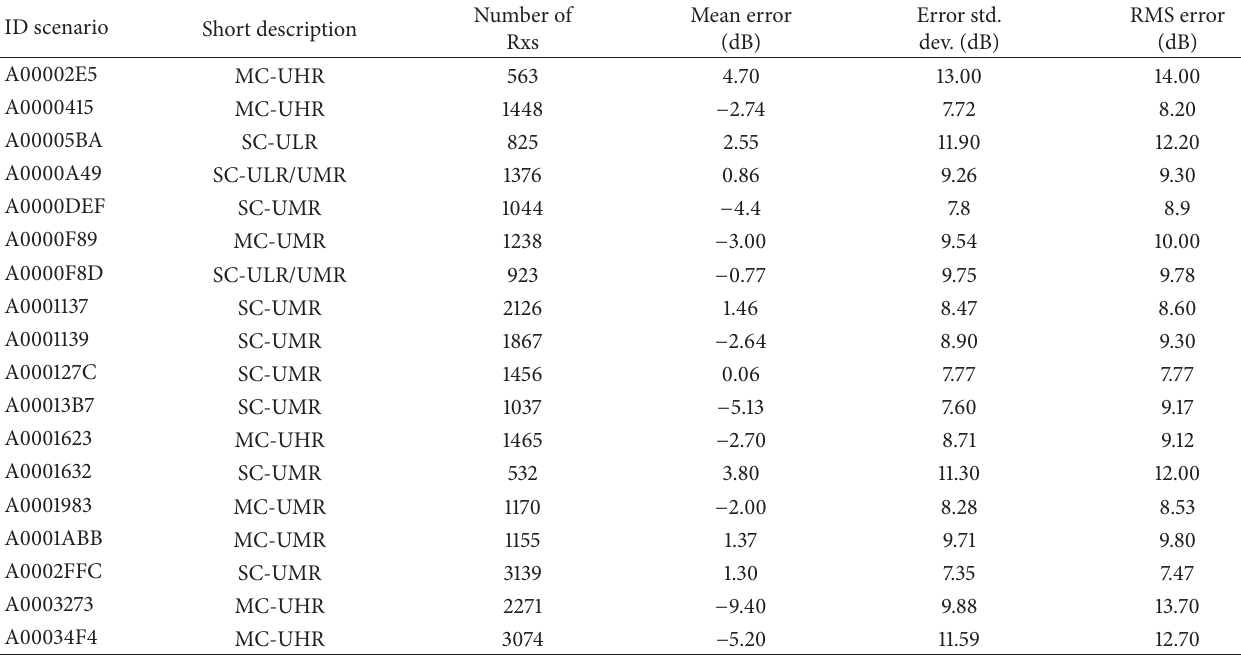
Table 2: Performance indicators for the 18 sites.